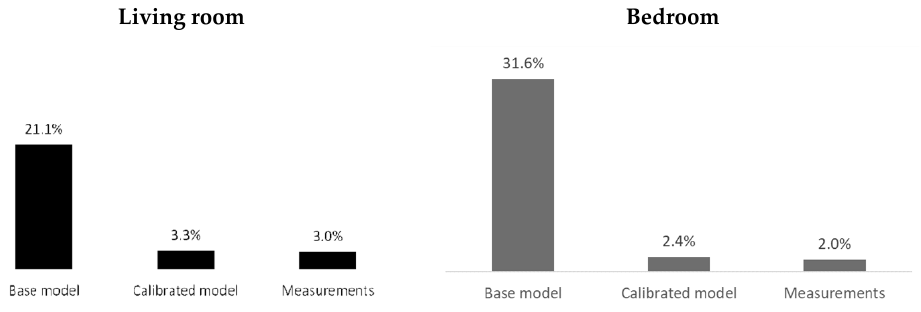
Figure 4. Models’ capability to estimate the time exceeding 25 °C in the living room ( left ) and in the main bedroom ( right ) compared to the measured values.